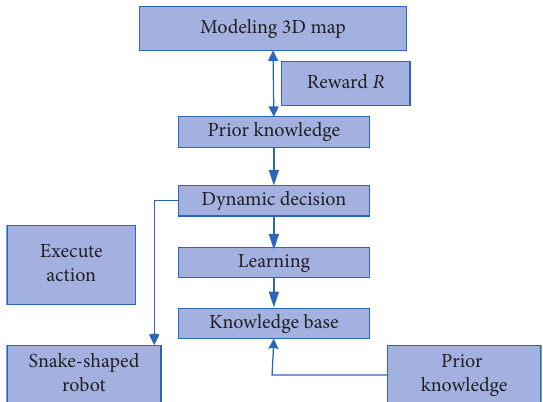
Figure 2: The snake-shaped robot path planning learning framework.